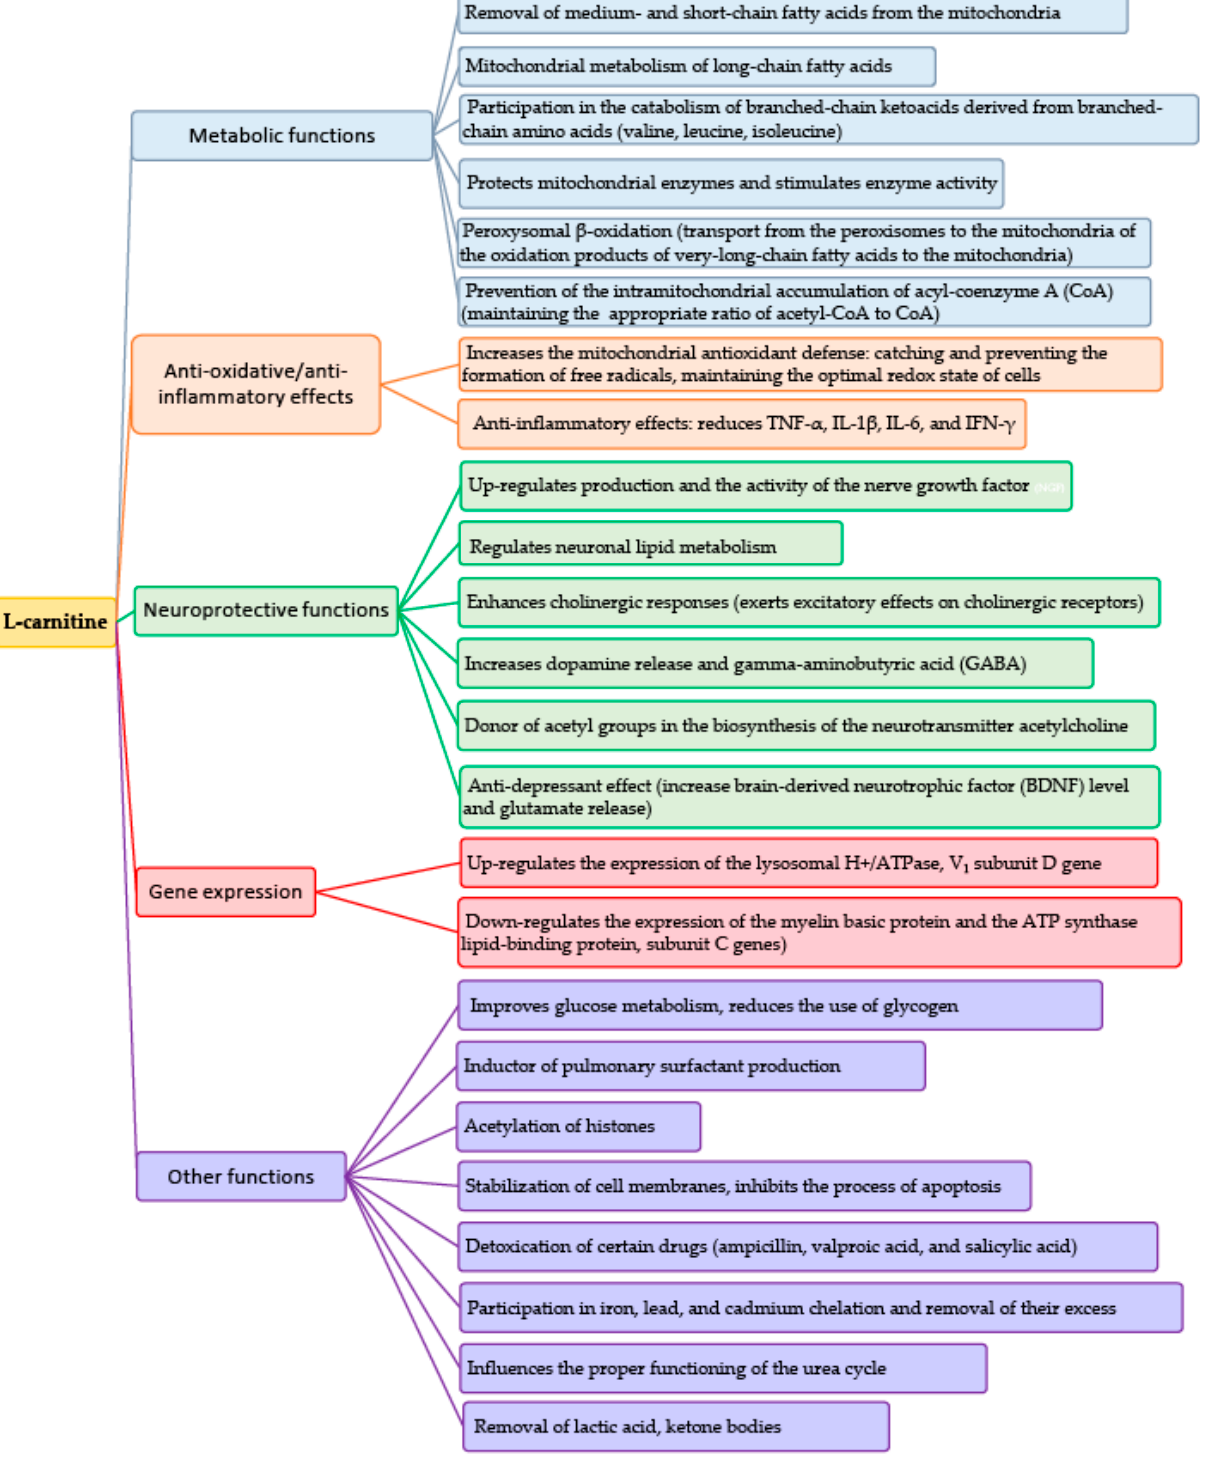
Figure 1. Roles of Figure 1. Roles of L-carnitine.